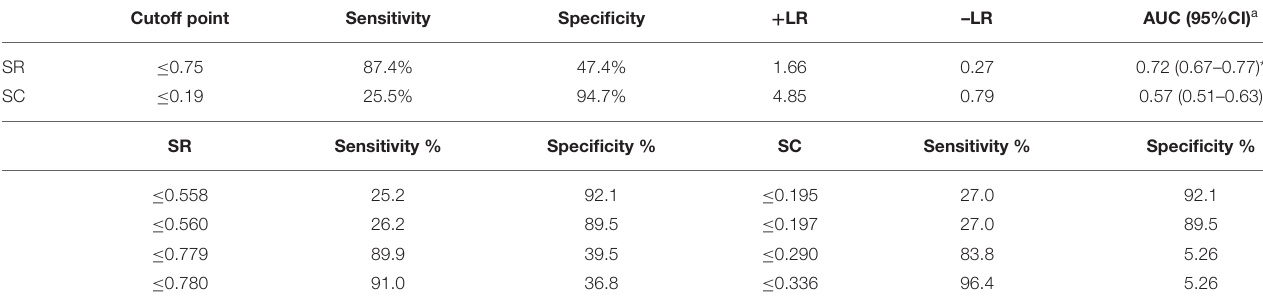
TABLE 4 | ROC analysis for differentiation of bulbar fistulae and prostatic/bladderneck fistulae from perineal fistulae. Cutoff